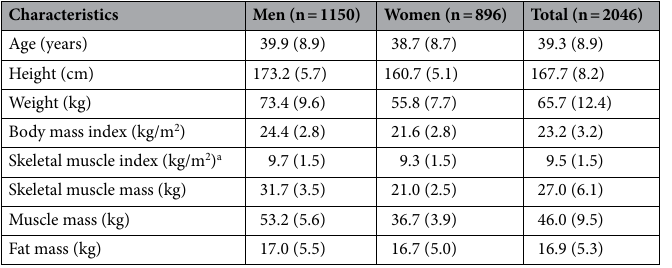
Table 1. Baseline characteristics of the study population. The data are presented as means (standard deviation). a Skeletal muscle index (kg/m 2 ) = skeletal muscle mass/height 2 .